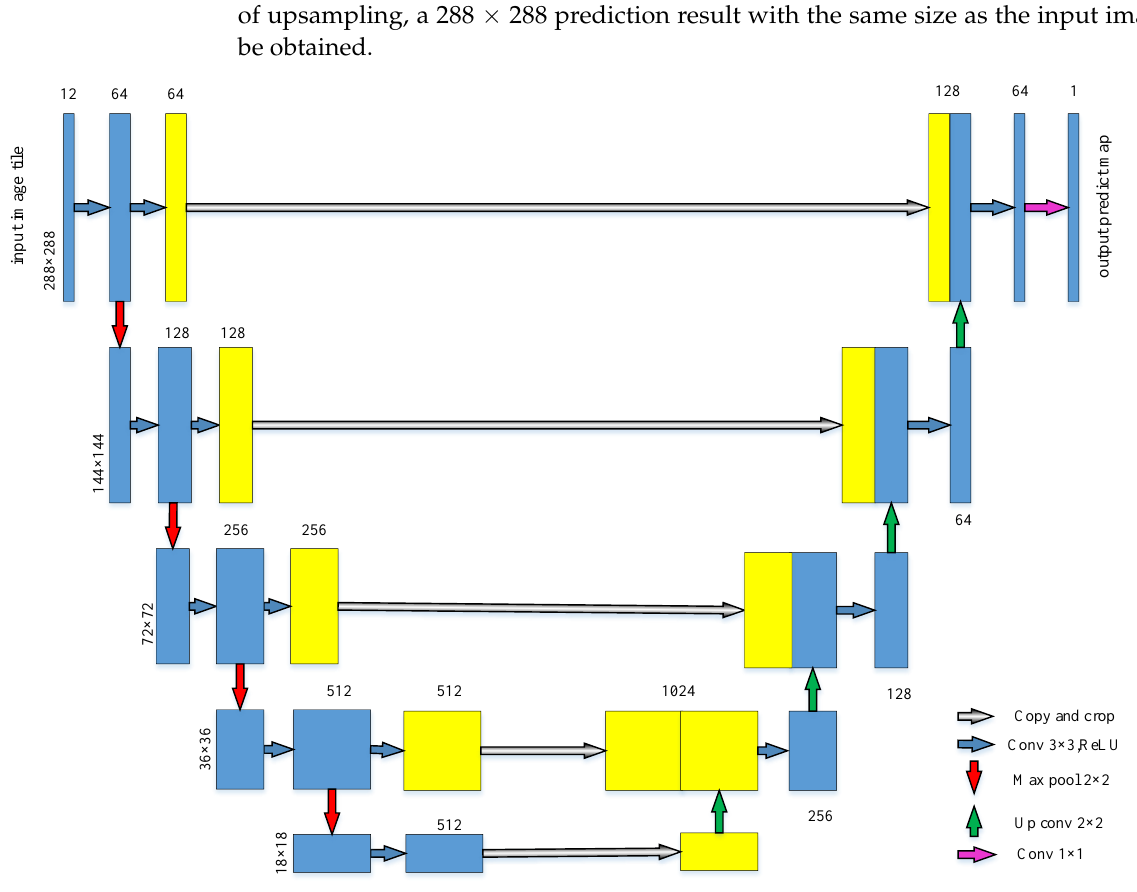
Figure 2. UNET Figure 2. UNET structure.